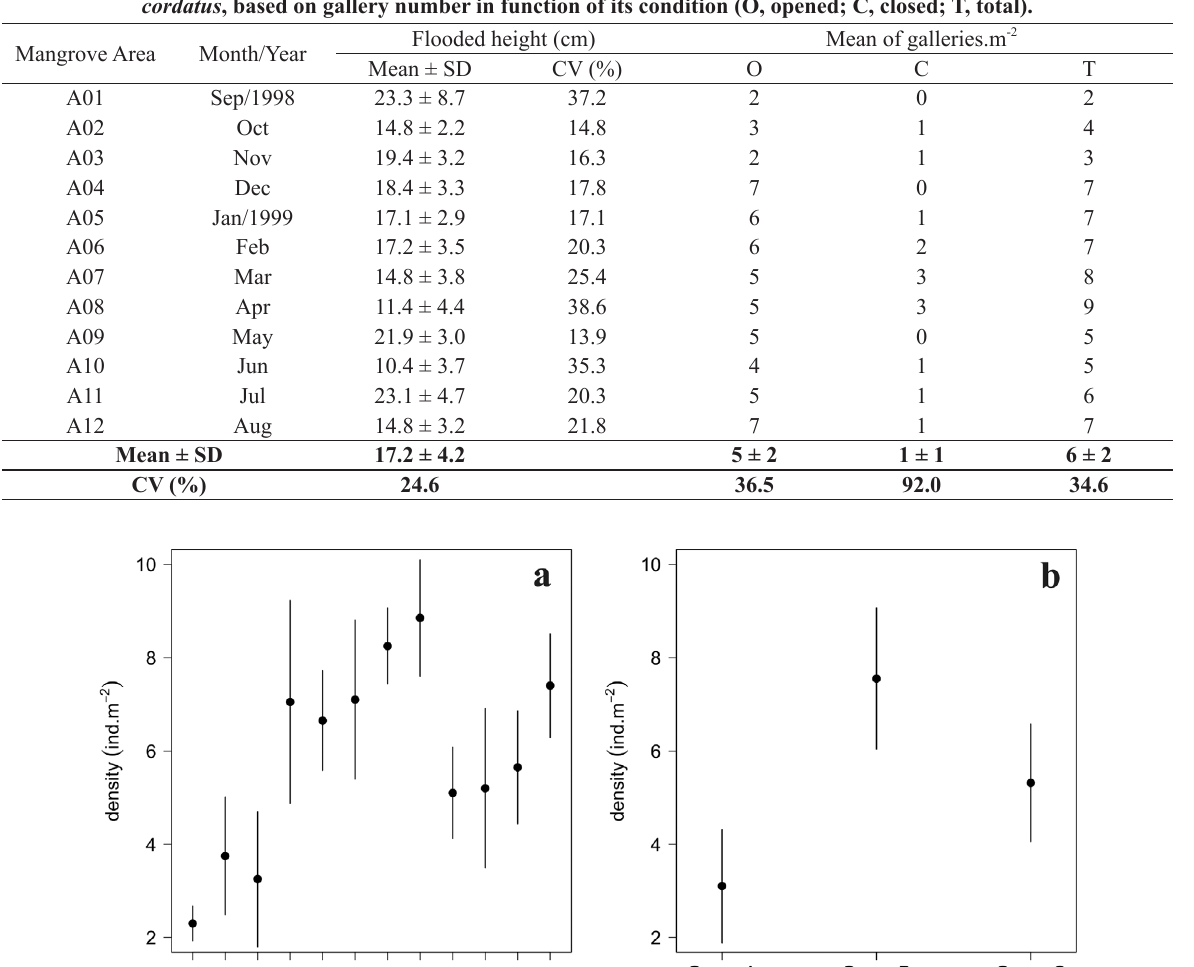
Flooded height (cm) of tides estimated based on the vertical distribution of ‘Bostrychietum’ on mangrove arboreal base, in each mangrove area monthly sampled during one year (September 1998 to August 1999), and respective densities of U. cordatus , based on gallery number in function of its condition (O, opened; C, closed; T, total).